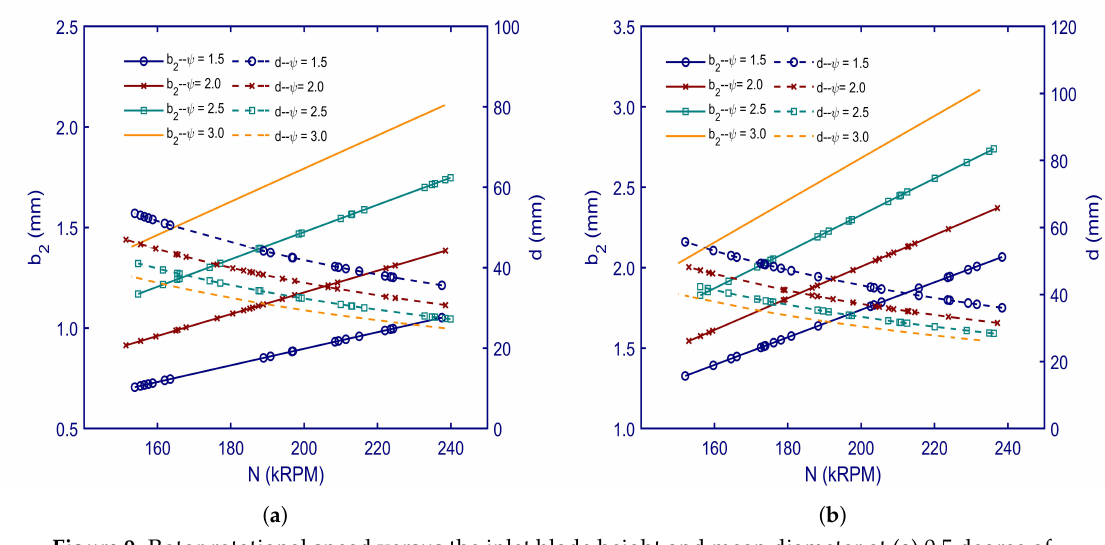
Figure 9. Rotor rotational speed versus the inlet blade height and mean diameter at ( a ) 0.5 degree of reaction ( b ) zero degree of reaction; blade height [b 2 ] is represented by the solid lines and diameter [d] is represented by the dashed lines.